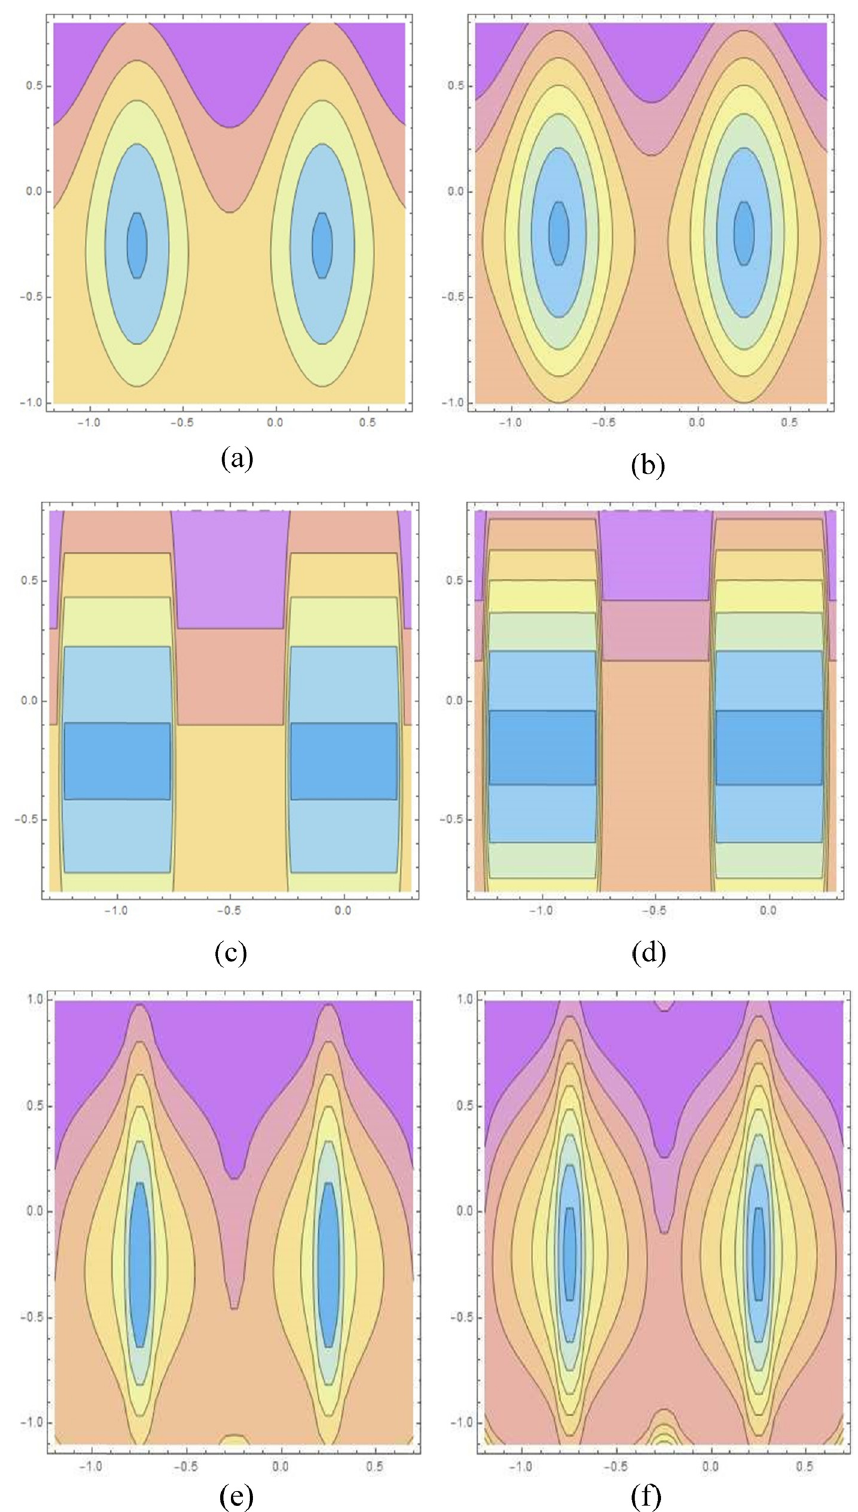
= 0.1, A = 2, Sr = 0.5 A = 1, Br = 0.5, K = 3, Sc = 0.5, ϵ 0.2 = , Gr 0.4 = , K = 2, 1 3 3 1